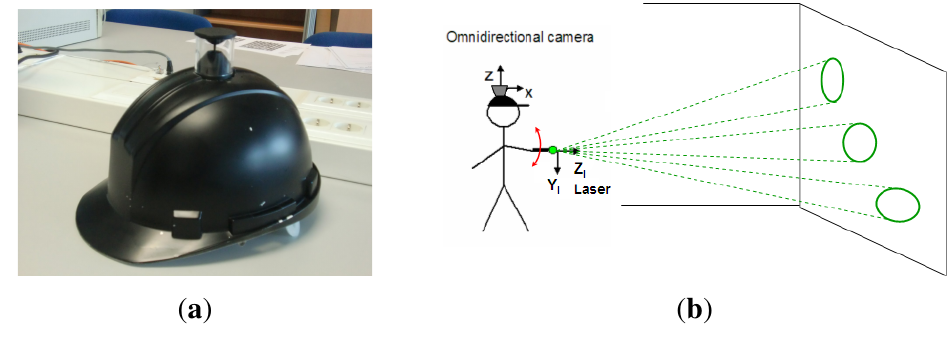
Figure 1. Flexible structured light system. ( a ) Wearable omnidirectional camera; ( b ) Configuration of the